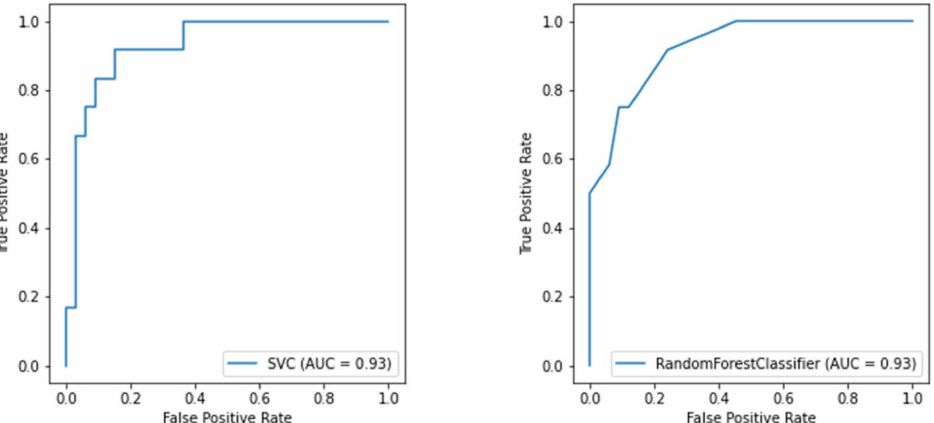
Figure 5. ROC curve of the SVM model for oxygen therapy classification (on the left ) and the ROC curve of the RF model for oxygen therapy classification (on the right